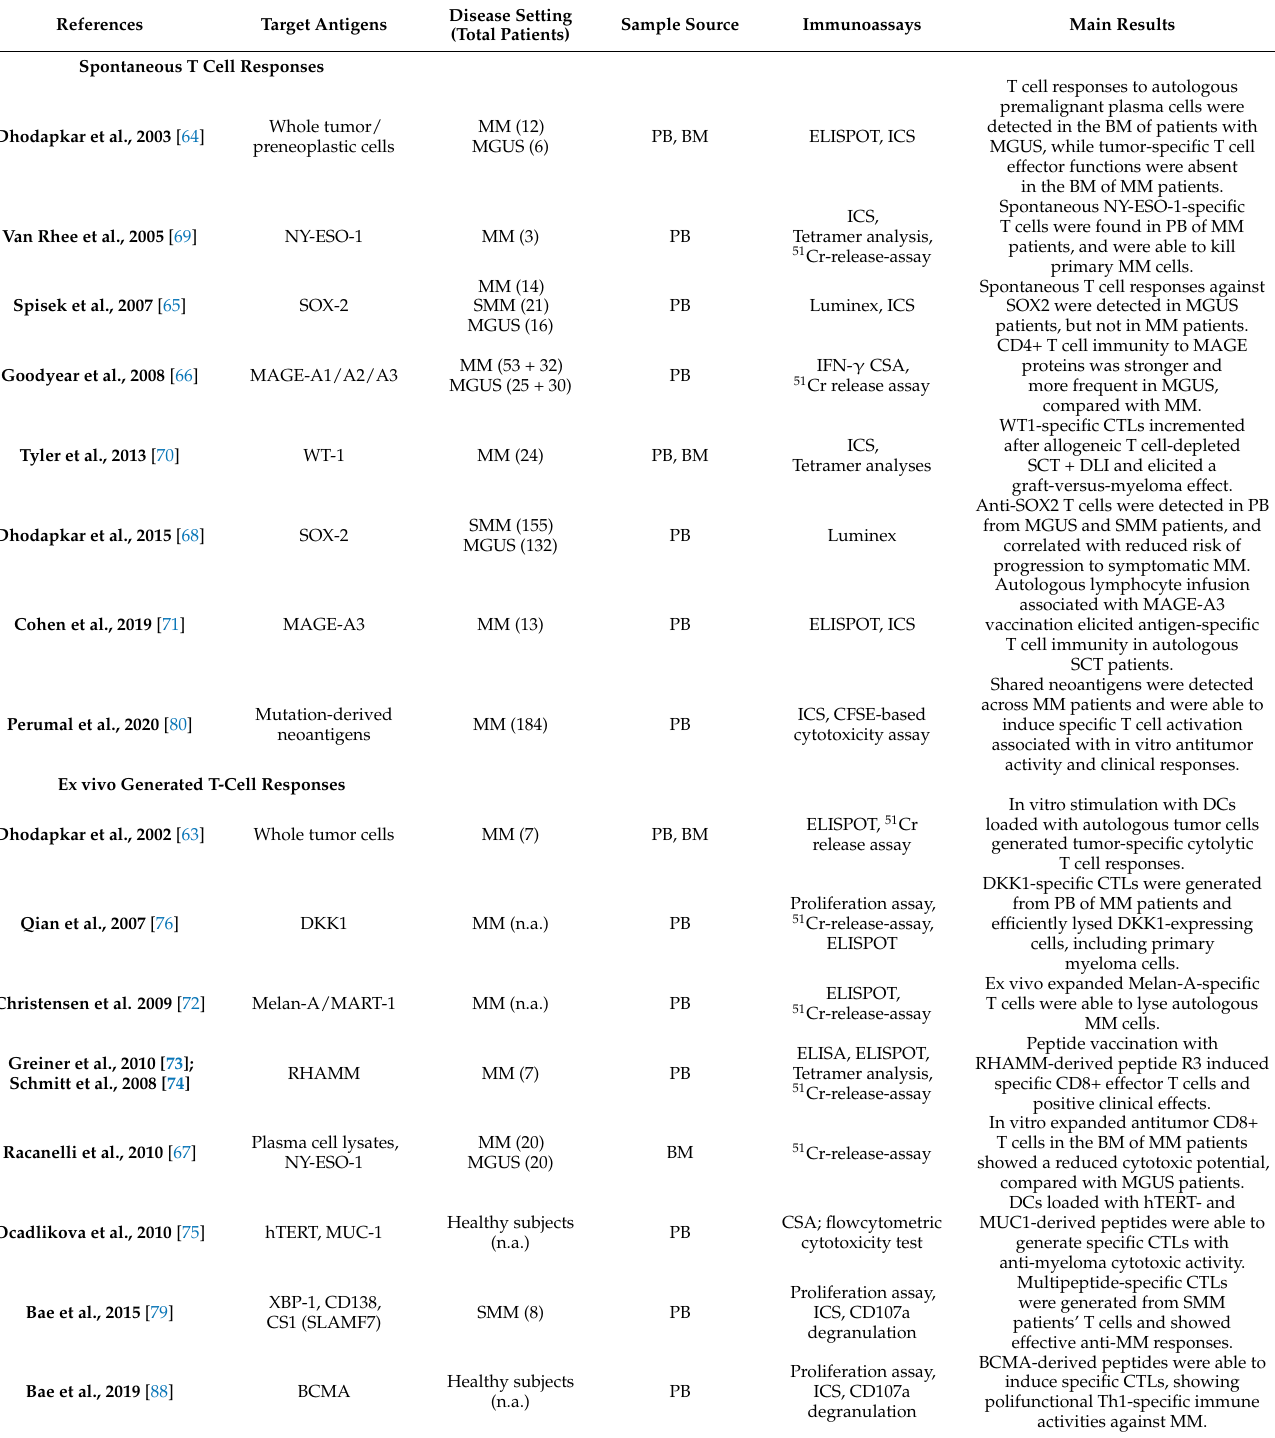
Table 1. Summary of main studies describing tumor-specific T cell responses in MM and MGUS